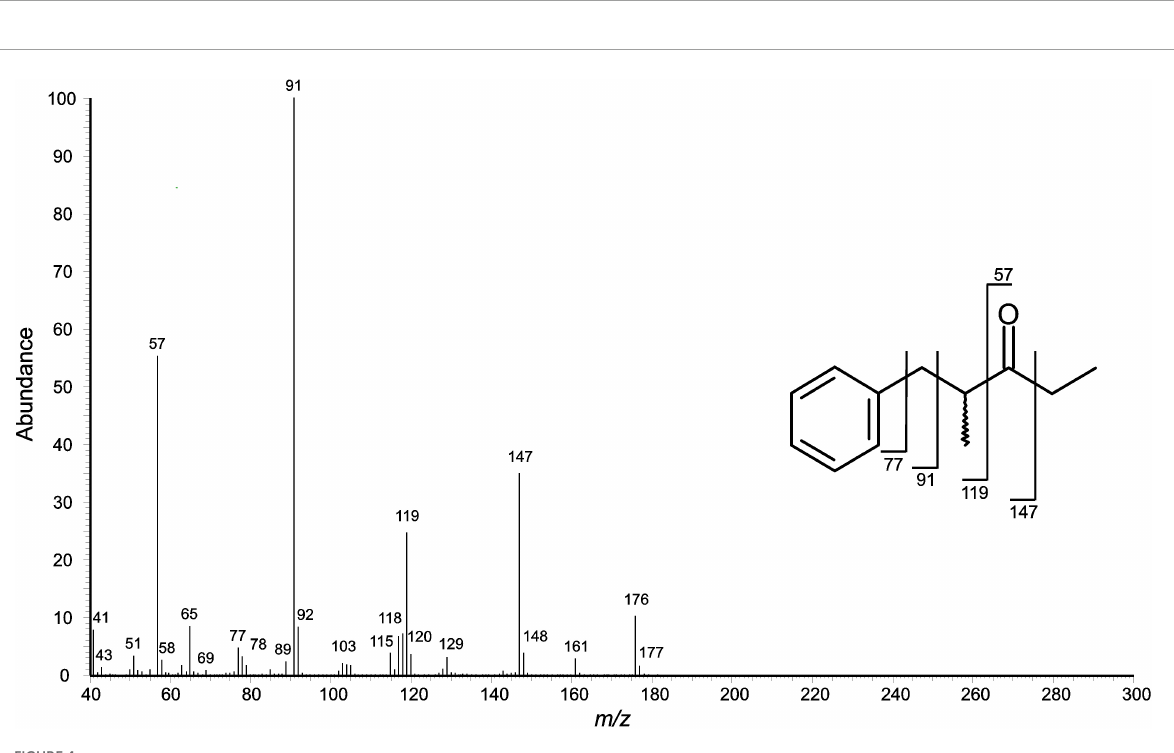
Frontiers in Ecology and Evolution